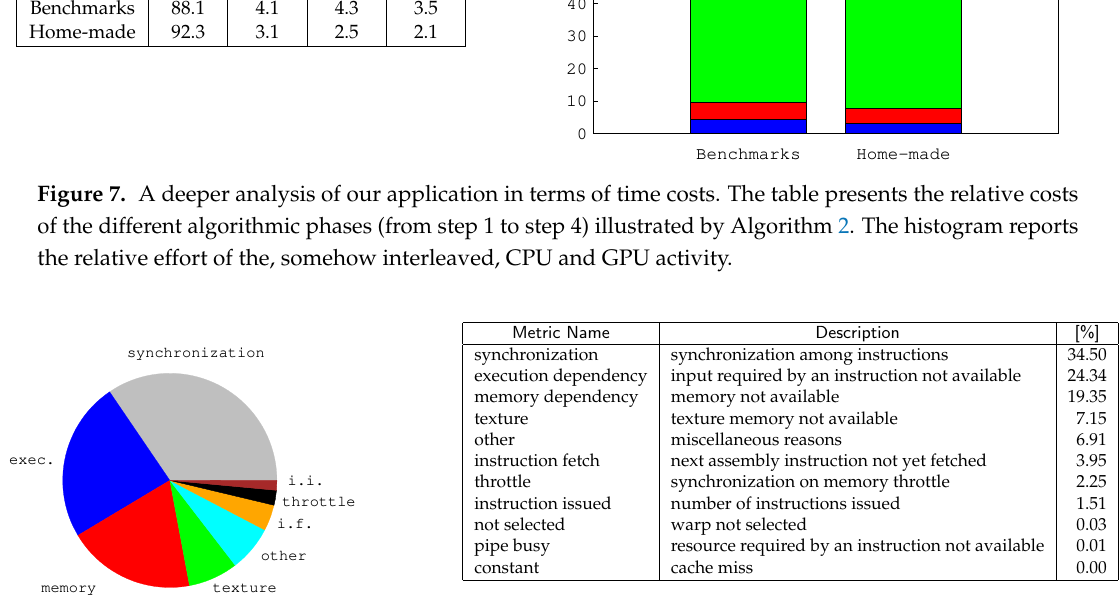
Figure 8. An analysis of our CUDA-based implementation with the NVIDIA profiling tool (Nsight). The chart represents all main reasons forcing a CUDA kernel function to stall, decreasing performances. The table reports the metric names, their descriptions (for the Compute Level 5.2) and the percentage of stalls in decreasing